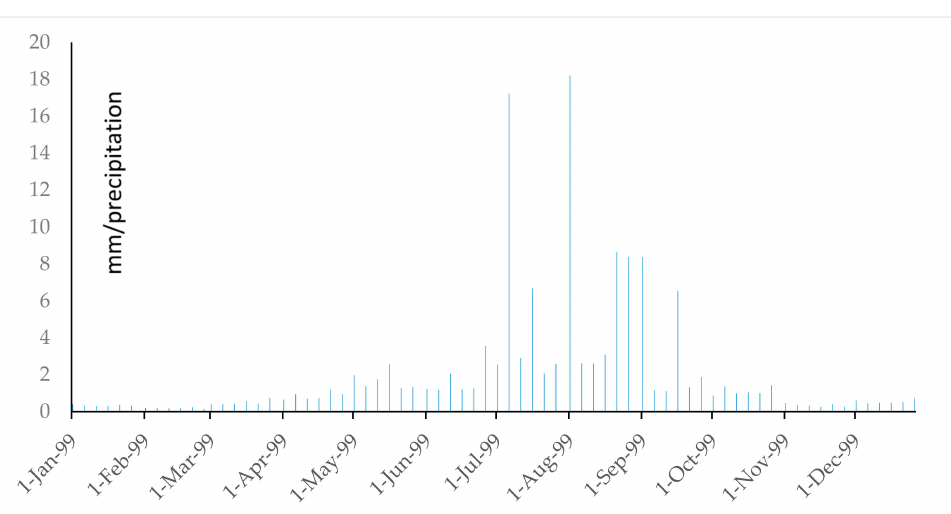
Figure A26. Precipitation of Denko County in 1998.